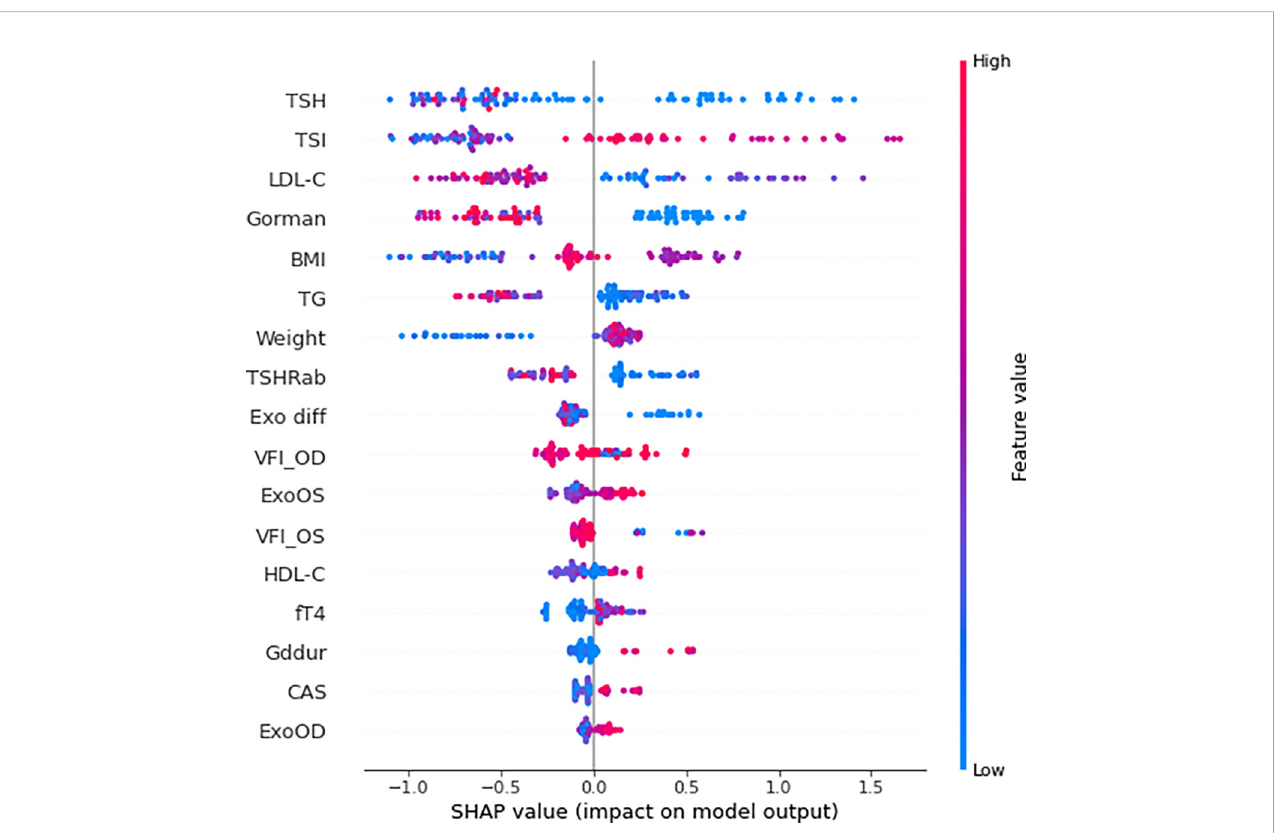
hormone receptor antibody; Exo diff differences of exophthalmos; VFI_OD visual fi eld index_oculus dexter; ExoOS exophthalmos in oculus sinister; VFI_OS visual fi eld index_oculus sinister; HDL-C high-density lipoprotein cholesterol; Gddur disease duration of graves disease; CAS clinical activity score; ExoOD exophthalmos in oculus dexter.